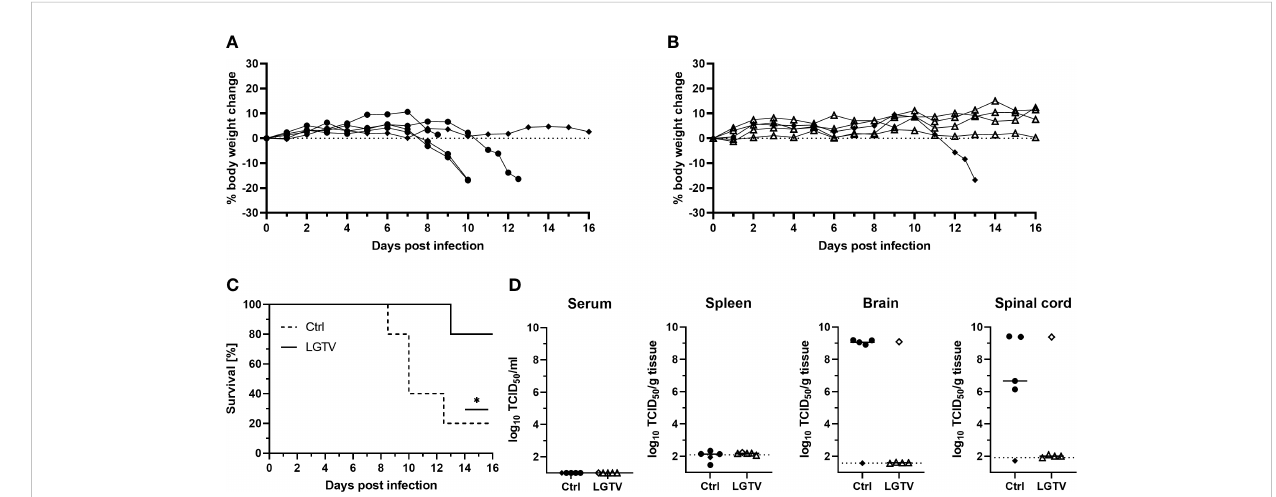
FIGURE 4 Immune serum from LGTV infected mice protects mice against subsequent TBEV challenge infection. Serum pooled from the respective group was i.p. injected into recipient mice (n=5). Following TBEV challenge infection, body weight of mice that received (A) control serum or (B) LGTV immune serum was monitored over a period of 16 dpi. Mice were taken out of experiment when the HEP was reached. (C) Survival curve plotted for the recipient mice that received control serum (dotted line) or serum from LGTV infected mice (solid line). Signi fi cant difference was analyzed by log rank test (p = 0.033). (D) TCID50 was performed on serum and tissue homogenates to determine the viral load in serum, spleen, brain and spinal cord of control ( (cid:129) ) or LGTV ( D ) serum recipients collected at the day of sacri fi ce. Median values are shown. Mice that differed in their clinical state from other mice in the control and LGTV serum recipient group are highlighted as rhombus shaped symbols.